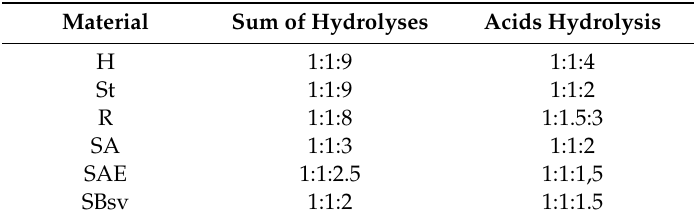
Table 3. Ratio of the share of vanillyl (V), syringyl (S), and cinnamyl (C) compounds V:S:C in hydrolysates of plant material (H, St, R) and soil (SA, SAE, SBsv). Material Sum of Hydrolyses Acids